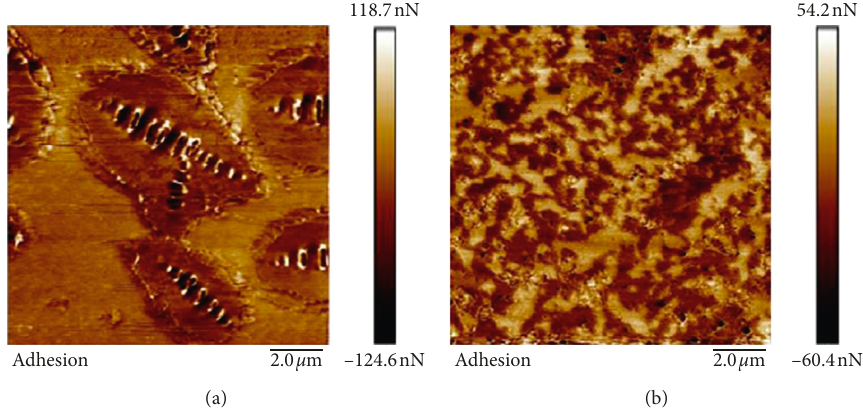
Figure 19: Micrograph of asphalt showing adhesion force overlay on a 20 × 20 micrometer